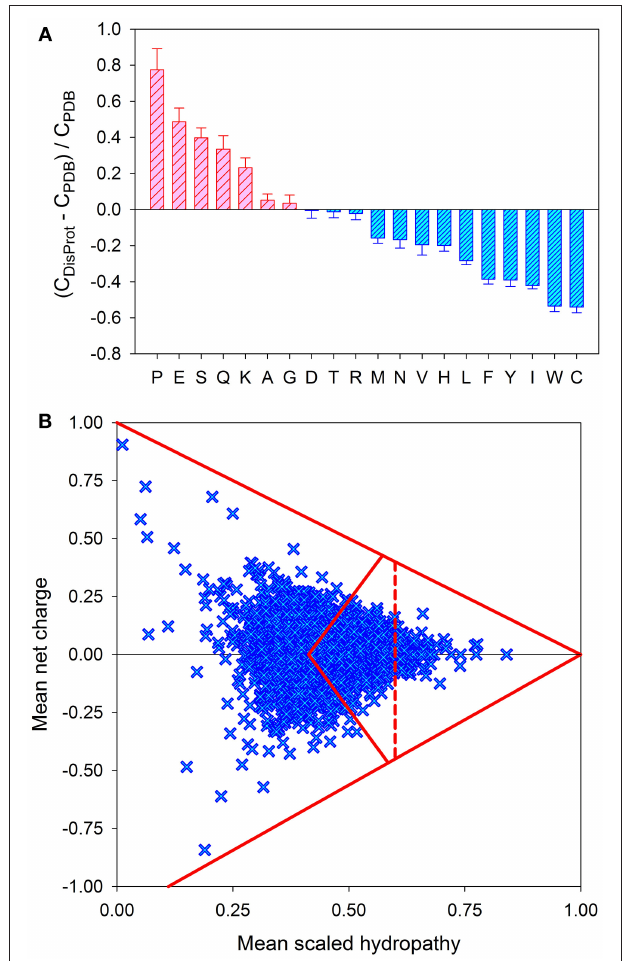
FIGURE 2 | Peculiarities of the amino acid sequences of IDPs. (A) Amino acid determinants defining structural and functional differences between the ordered and intrinsically disordered proteins. Fractional difference in the amino acid composition (compositional profile) between the typical IDPs from the DisProt database [47] and a set of completely ordered proteins [48] calculated for each amino acid residue. The fractional difference was evaluated as (C DisProt -C PDB )/C PDB , where C DisProt is the content of a given amino acid in a DisProt database [47] and C PDB is the corresponding content in the dataset of fully ordered proteins from PDB select 25 [48]. Positive bars correspond to residues found more abundantly in IDPs, whereas negative bars show residues in which IDPs are depleted. Amino acid types were ranked according to their decreasing disorder-promoting potential [49]. (B) Evaluation of the charge-hydropathy space available for mouse proteins. In this plot, each protein is represented by a single point calculated based on its mean net charge and mean net hydropathy. This plot differs from the traditional charge-hydropathy plot (CH-plot) [40] by showing both positive and negative mean net charge values instead of the absolute mean net charges. The area accessible to sequences encoding ordered and disordered proteins are defined by several boundaries: (i) the known boundary separating compact proteins and extended IDPs ( < R > = 2.785 < H > − 1.151, where < R > and < H > correspond to the absolute mean charge and mean hydropathy, respectively [40]); (ii) the mirror image of this boundary ( < R > = − 2. 785 < H > + 1.151, where < R > and < H > correspond to the mean charge and mean hydropathy, respectively), which is included to consider negatively charged proteins; (iii) two boundaries showing logical limits of the CH-space